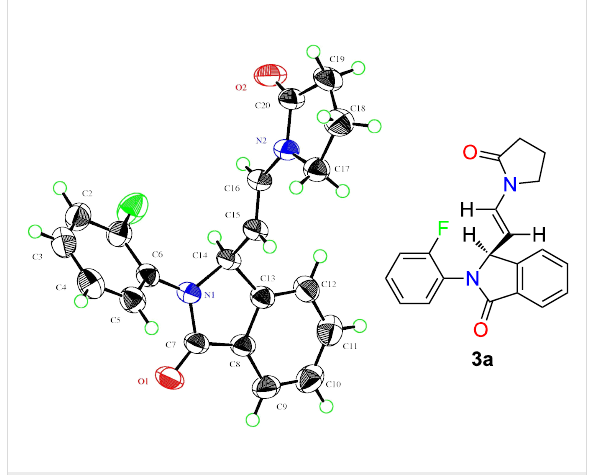
Figure 3: ORTEP diagram and 2D structure of E -2-(2-fluorophenyl)-3- (2-(2-oxopyrrolidin-1-yl)vinyl)isoindolin-1-one ( 3a